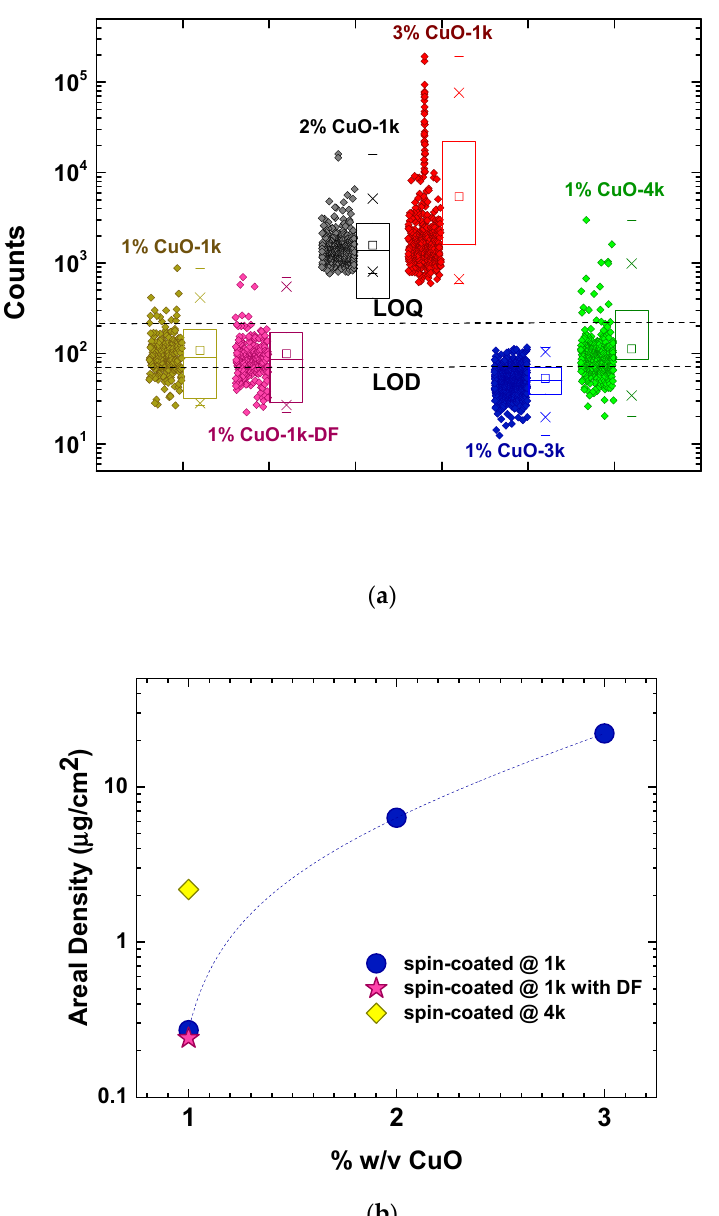
Figure 5. Synopsis of μ XRF measurements for all CuO/PMMA samples (Phase 1). ( a ) Scattered solid diamonds depict the intensity signal from each point (pixel), while open squares show the average signal value. The large rectangles show the range between 25% and 75% of the maximum obtained signal, the crosses mark the range between 1% and 99% of the maximum obtained signal and the horizontal dashes show the minimum and maximum obtained values. Dashed lines show the limit of detection (LOD) and the limit of quantification (LOQ) set as 3*LOD. ( b ) Cu areal density as a function of the nanofiller loading and the preparation parameters. Blue circles: films of various loadings spin-coated at 1 krpm; Magenta star: sample 1%CuO-1k-DF with 1% CuO nanofillers and deflocculant spin-coated at 1 krpm; Yellow diamond: sample 1%CuO-4k with 1% CuO nanofillers and spin-coated at 4 krpm.